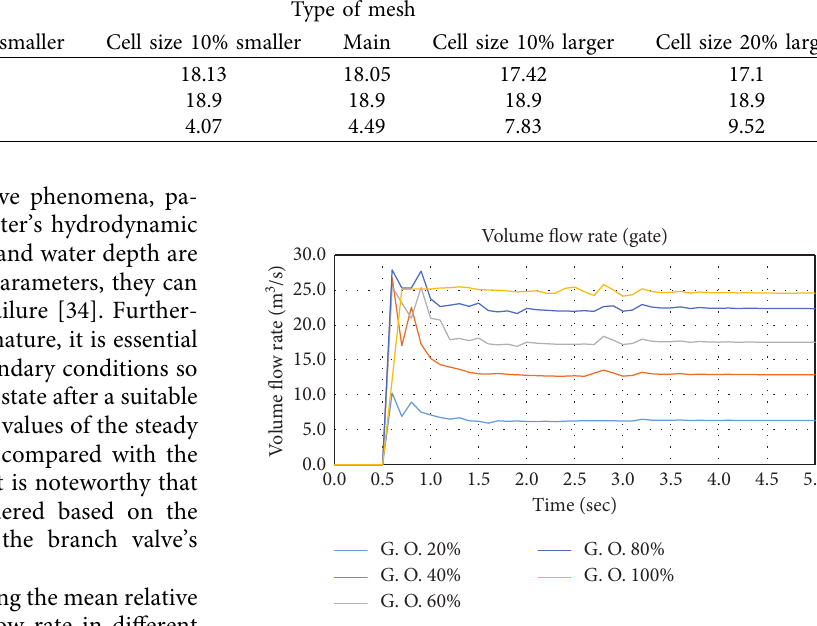
Figure 7: Numerical model results for output flow rate at various gate openings during Flow-3D numerical model